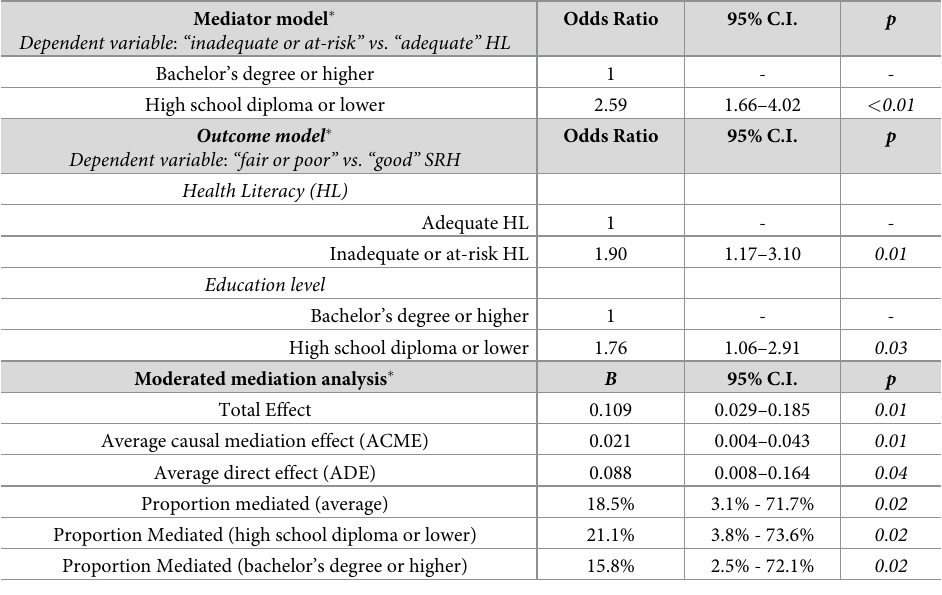
Table 2. Mediator model, outcome model and moderated mediation analysis for education level. Mediator model �